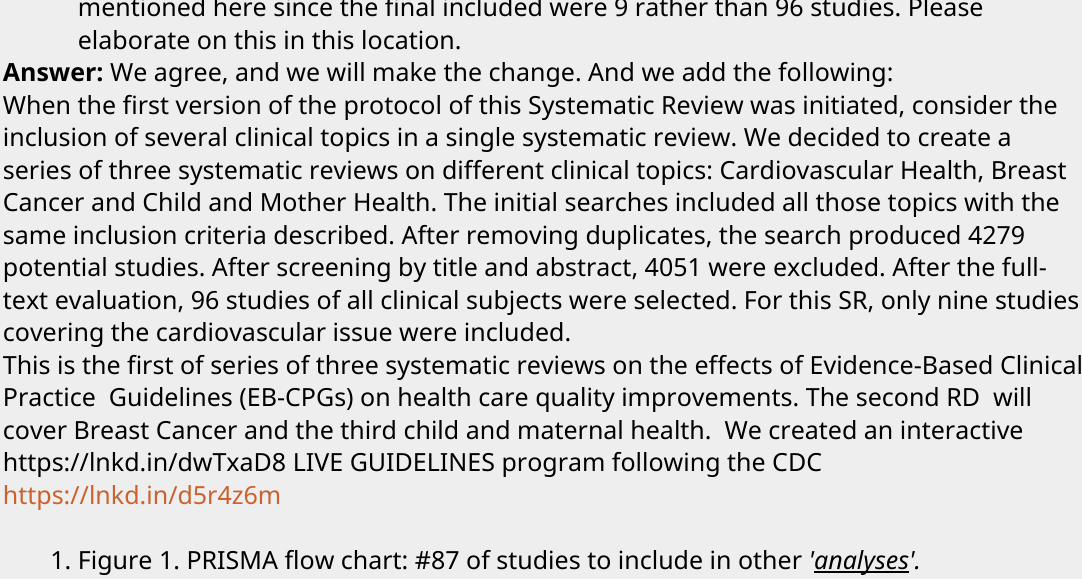
Figure 1. PRISMA flow chart: #87 of studies to include in other 'analyses'.